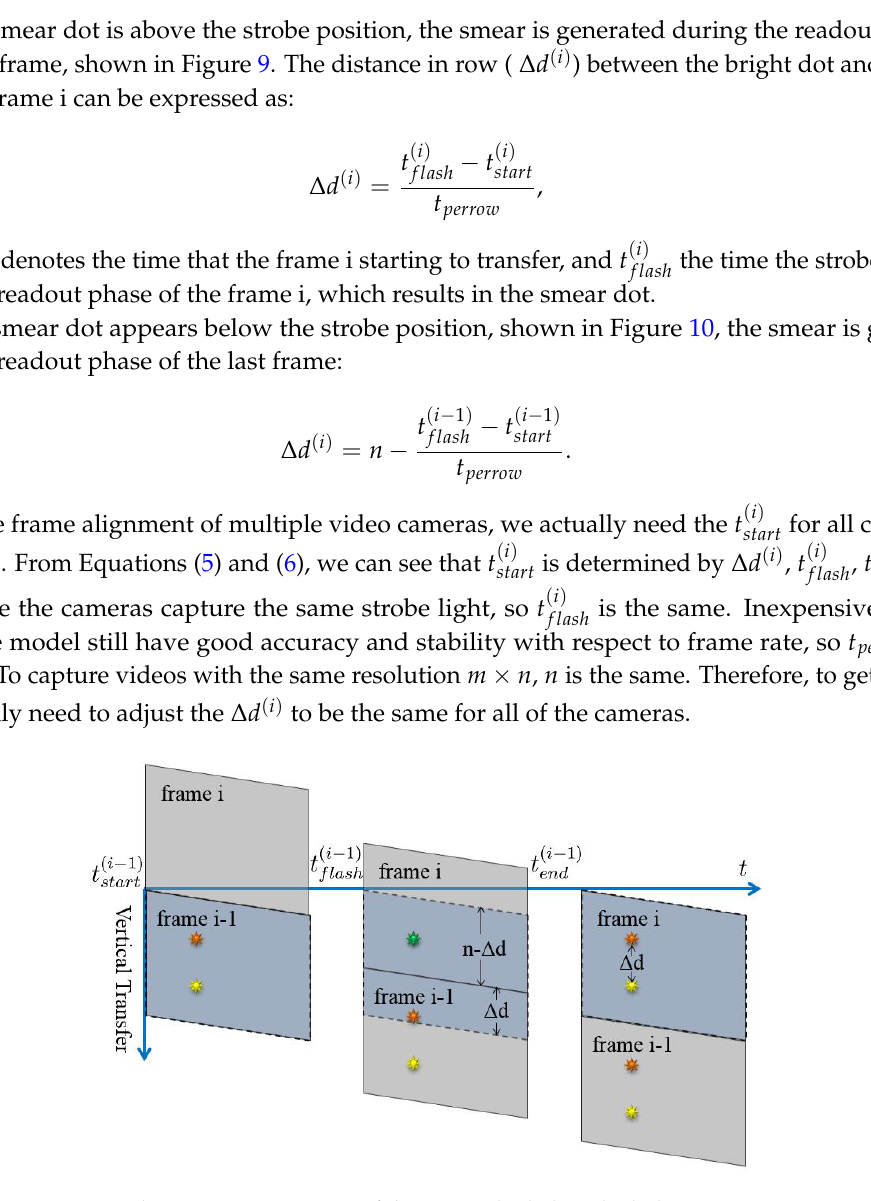
Figure 10. The generation process of the smear dot below the light source